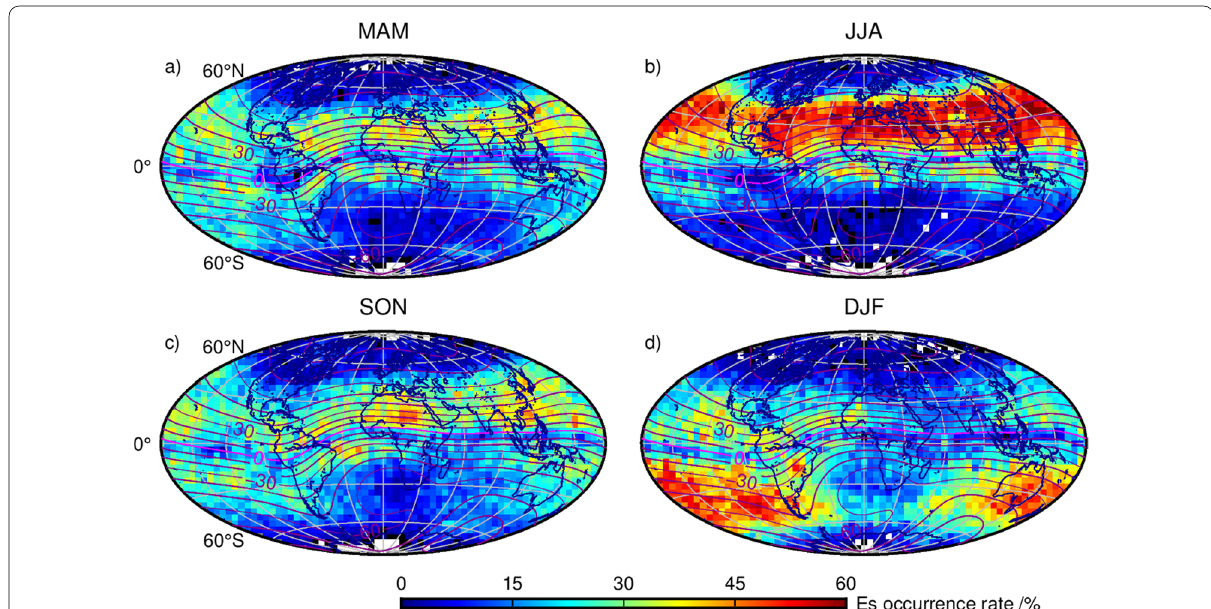
Fig. 5 Seasonal variation in the horizontal distributions of the FY-3C RO-derived Es occurrence rates during Jan. 2015 to Dec. 2019, with the resolution of a 5° 5° grid. Plots for a March, April and May (MAM); b Jun, July, and August (JJA); c September, October, and November (SON), and × d December, January, and February (DJF). In each subfigure, the pink curve represents the geomagnetic equator and the red curves represent the geomagnetic inclination